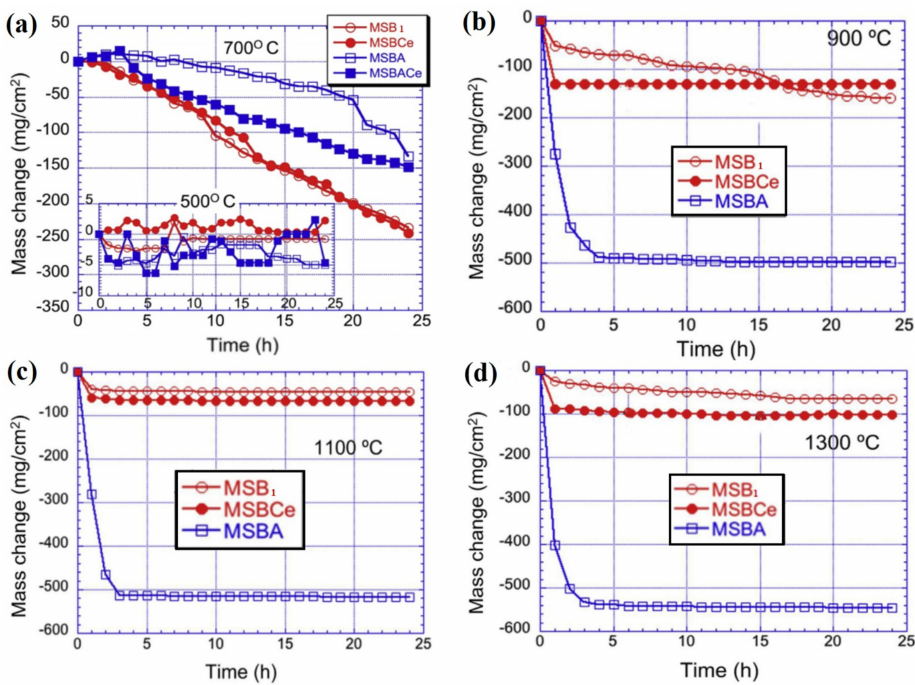
Figure 6. Mass loss curves of various alloys at different temperatures. ( a ) and ( b – d ) reproduced with permission from [102] and [103], respectively. Copyright 2010 Elsevier and 2016 Elsevier.